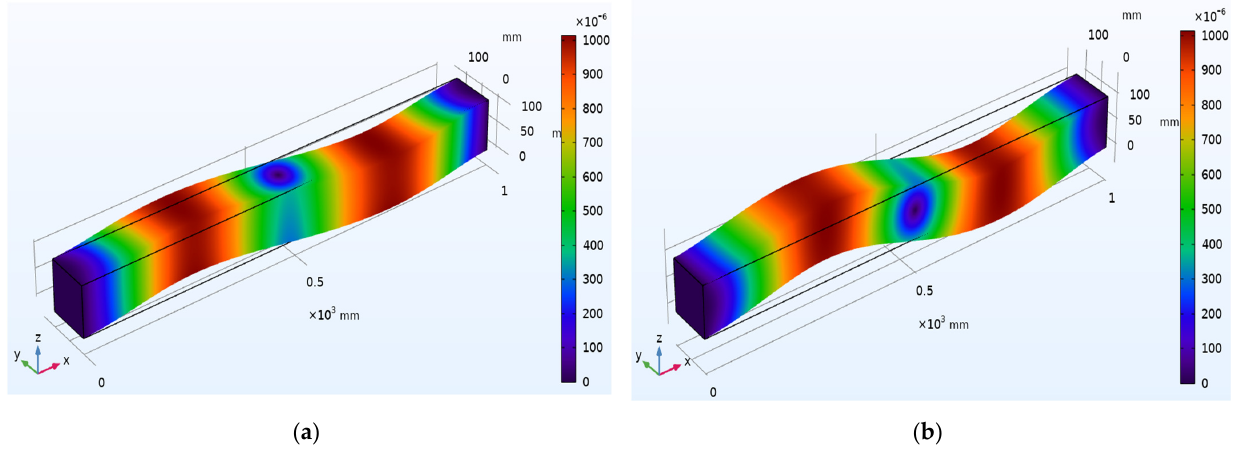
Figure 4. Surface displacement contours of beam for flexural mode shapes: ( a ) First mode; ( b ) Second mode.